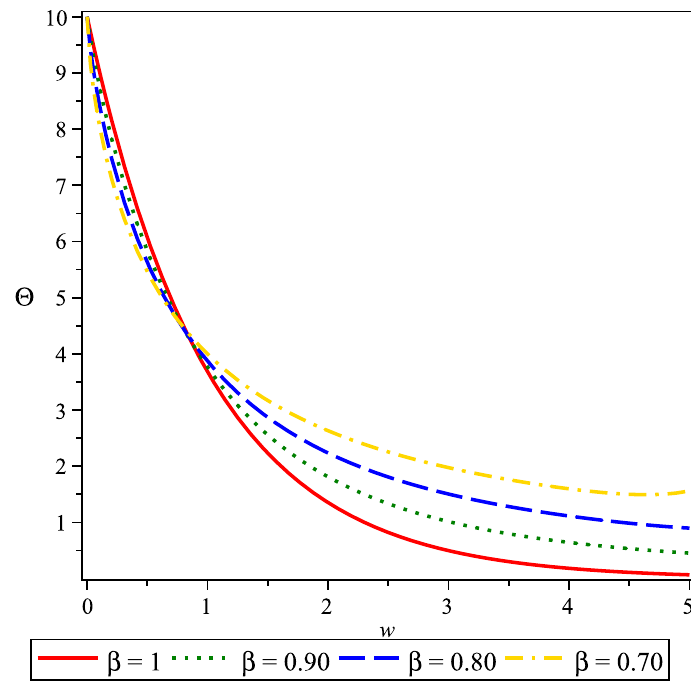
Figure 2. Plots of solution Θ for FKE (25) when Θ 0 = 10, ℘ = 0, and c =